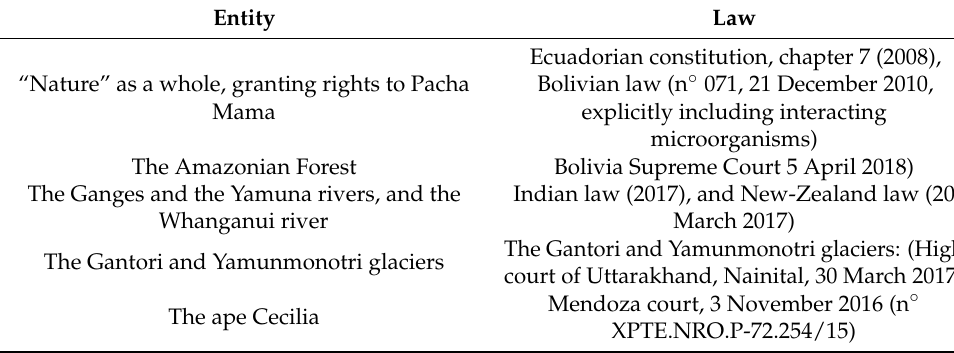
Table 2. Some recognized non-human right